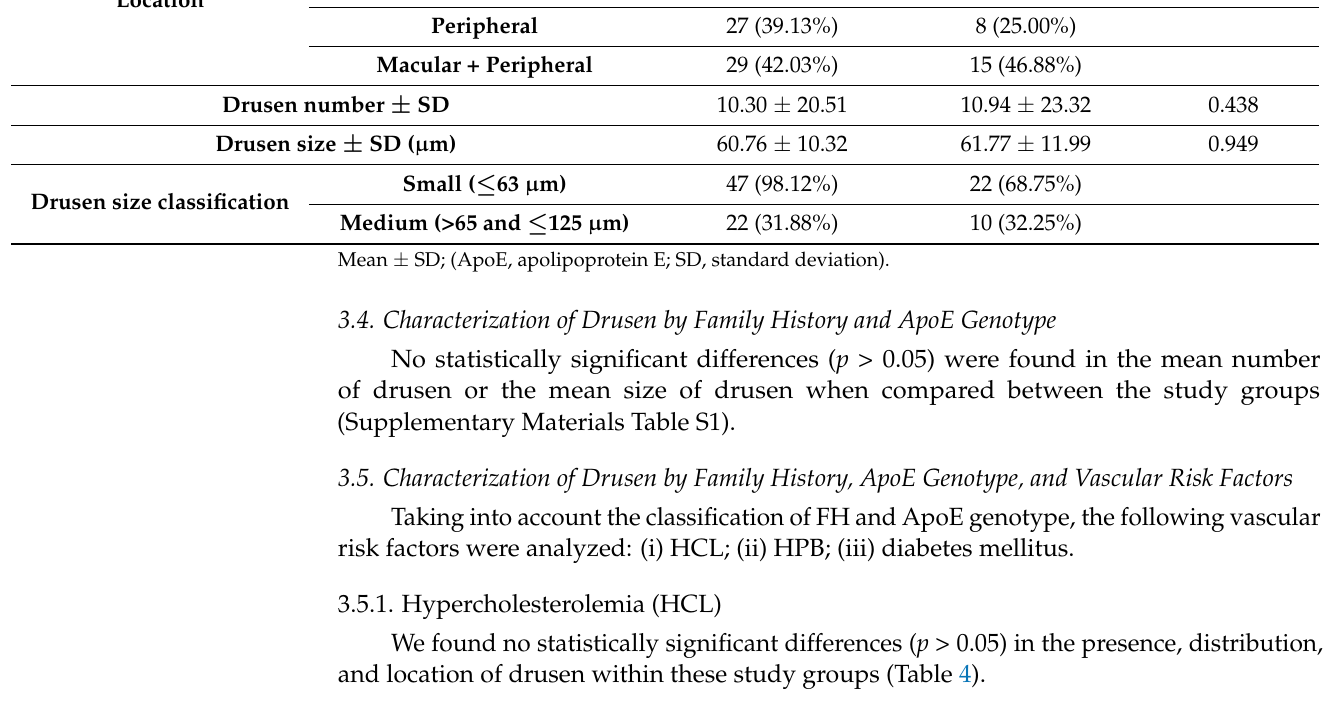
Table 4. Characterization of drusen by FH, ApoE genotype, and